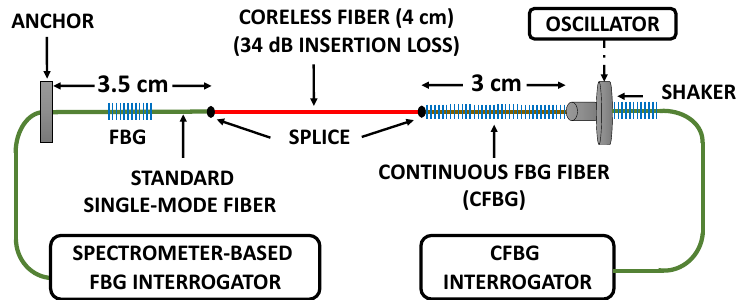
Figure 12. Setup for the CFBG experiment, using a polyimide-coated composite FUT. Taking ad- vantage of the high spatial resolution of the CFBG interrogator (<1 cm), a very short CFBG fiber is used. The coreless fiber segment, serving as a high insertion loss, bidirectional isolator, allows for the CFBG interrogation to be augmented by an independent and simultaneous uniformly triggered FBG interrogation of the FUT vibrations.